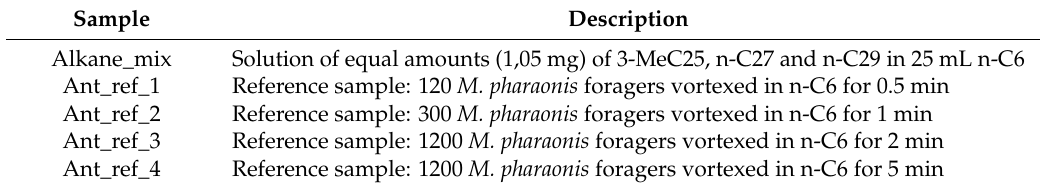
Table 8. List of reference samples and alkane mixture to be loaded onto the zeolites. Sample